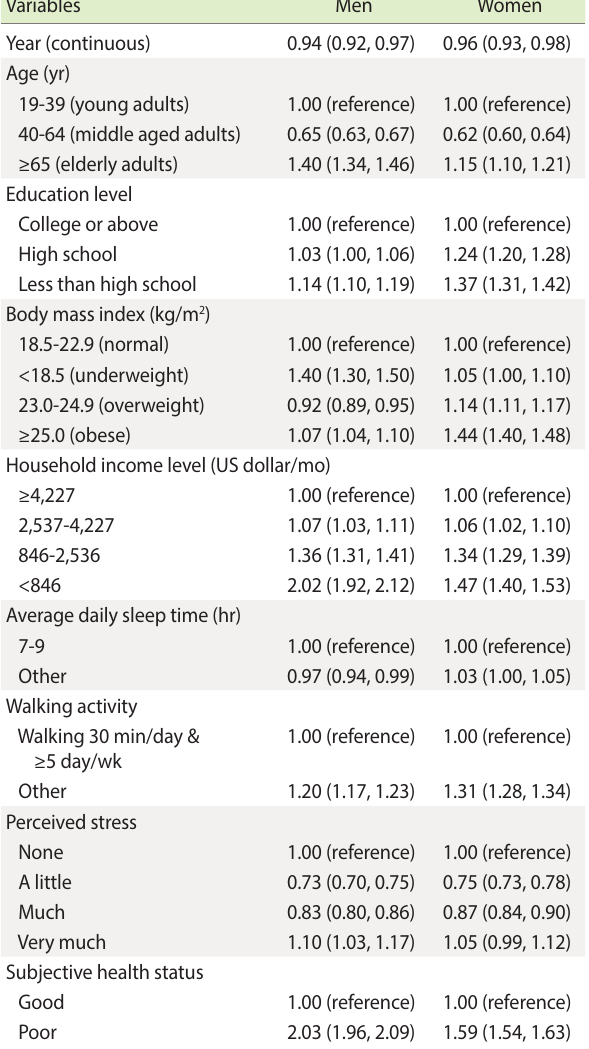
Table 3. Weighted logistic regression models 1 of leisure-time sed- entary behavior, adjusted for socio-demographic and lifestyle char- acteristics, using 2011-2017 Korea Community Health Survey